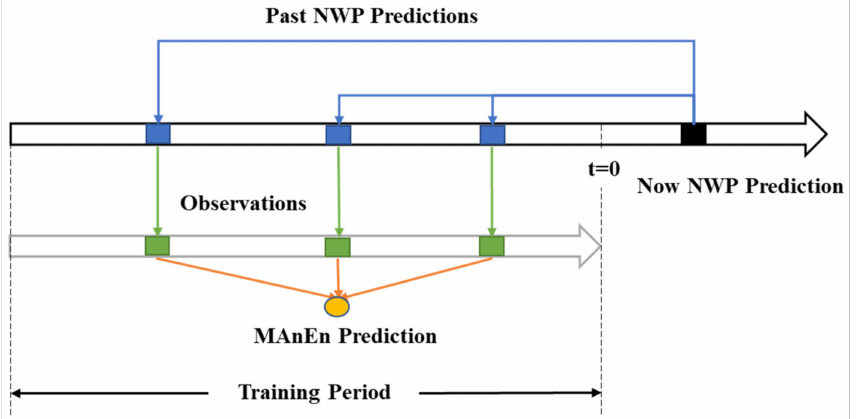
Figure 1. Flow chart of the analogue ensemble averaging method